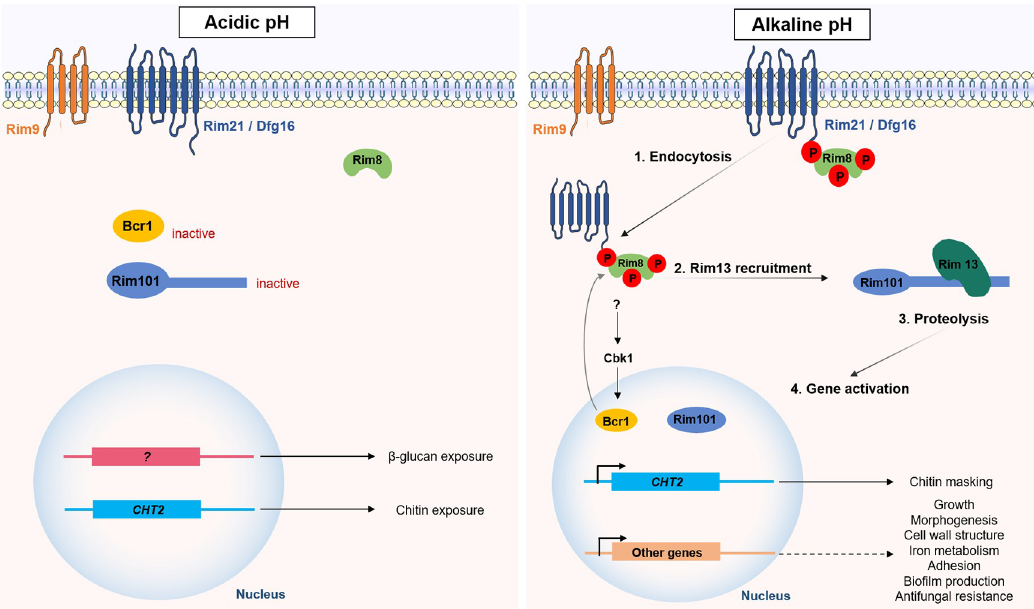
Fig 3. Candida adaptation to pH fluctuations. In Candida species, pH adaptation is mediated by the Rim pathway. Under acidic pH, the exposure of both chitin and β -glucan is enhanced and facilitates their recognition by the host innate immune system. Chitin exposure is promoted by the repression of both Rim101 and Bcr1, resulting in reduced expression of CHT2 . β -glucan exposure is regulated by a noncanonical signaling pathway. Under alkaline pH, Rim8 is hyperphosphorylated, a signal that induces the endocytosis of the Rim complex and the recruitment of Rim13. The C-terminal proteolysis of Rim101 by Rim13 activates it and promotes the expression of target genes, including CHT2